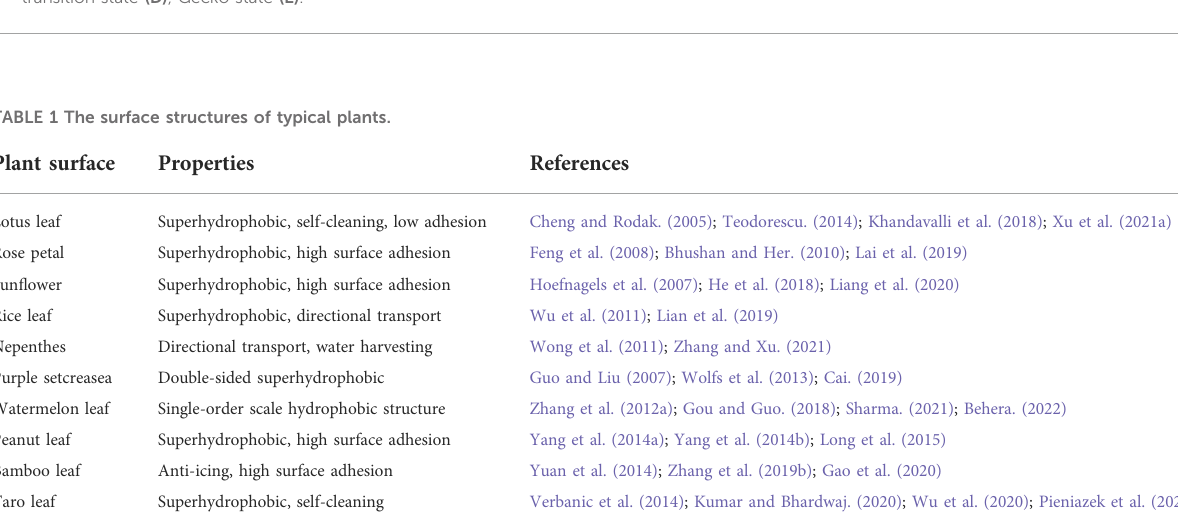
FIGURE 3 Diagramoftheexistencestateofdropletson fi vesuperhydrophobicsurfaces:Wenzel ’ sstate (A) ,Cassiestate (B) ,Lotusstate (C) ,Wenzel-Cassie transition state (D) , Gecko state (E) .